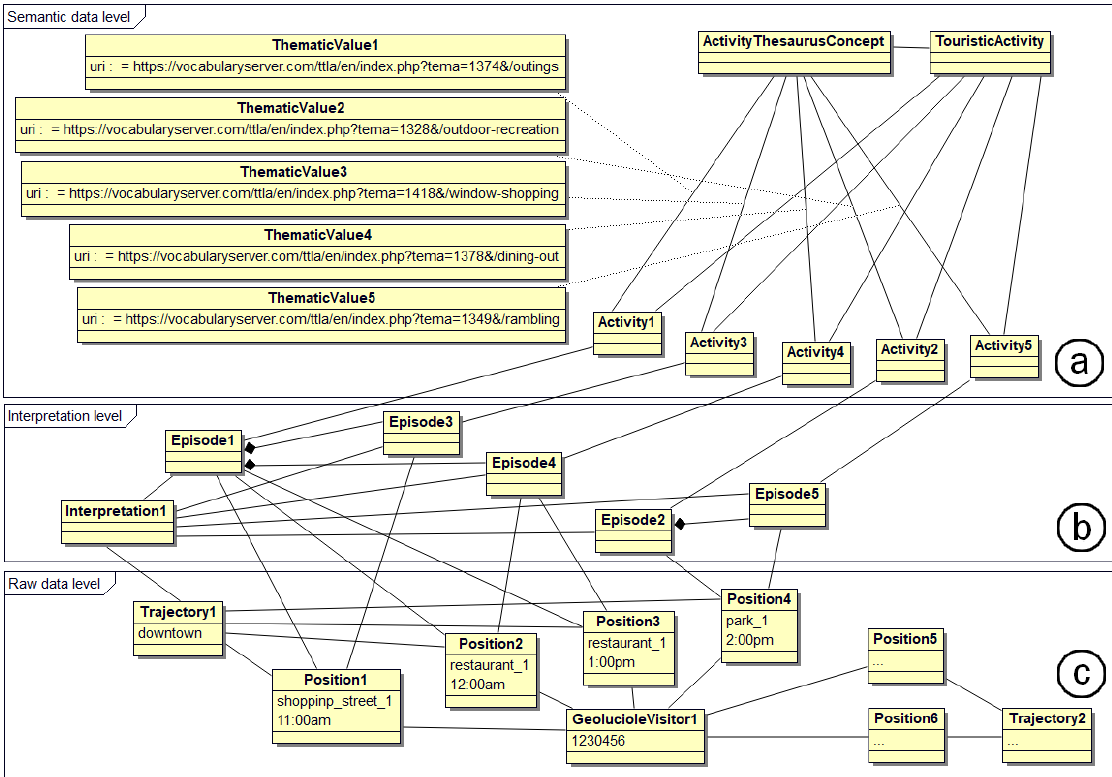
Figure 8. Instantiation of the model just after the thematic enrichment with touristic activities to answer question